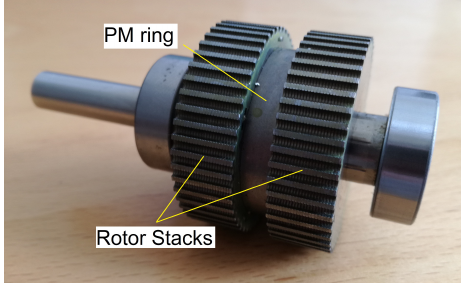
Figure 1. Hybrid rotor